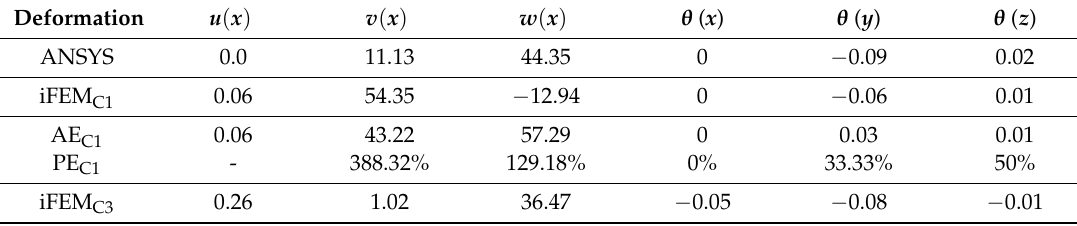
Table 7. Comparisons among deformations computed with iFEM and deformations extracted from ANSYS in case of complex loads (Loading C). Strain inputs contained